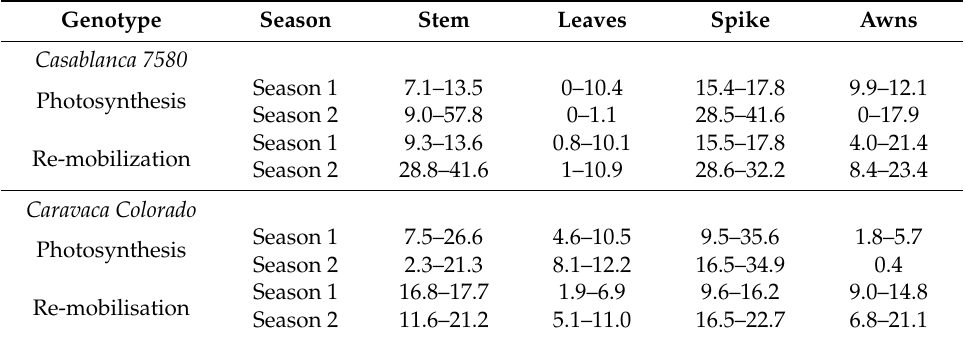
Table 3. Estimation of the relative contribution (expressed in %) of stem, leaf, spike, and awn photosynthesis and re-mobilisation to thousand kernel weight in cultivars Casablanca 7580